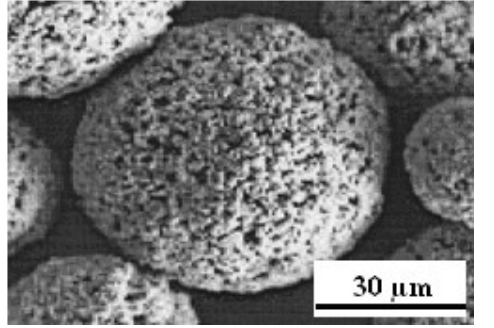
Figure 2 – (SEM) Scanning electron micrograph of WC17Co powder